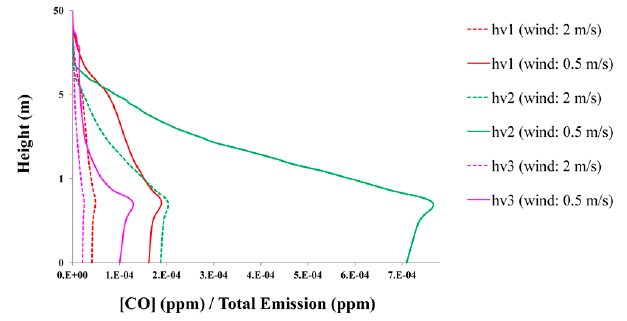
Figure 12. Double averaged profiles of CO concentration in the 3 hypothetical cases with wind velocities of 0.5 and 2 m/s.